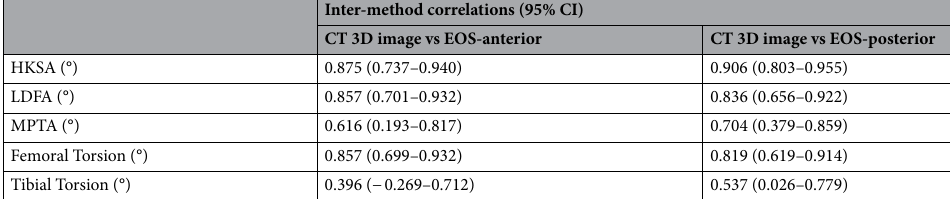
Table 3. Inter-modality correlation (95% CI) of the alignment parameters between full-length lower extremity CT 3D images and EOS 3D images. 3D three-dimensional, CT computed tomography, CI confidence